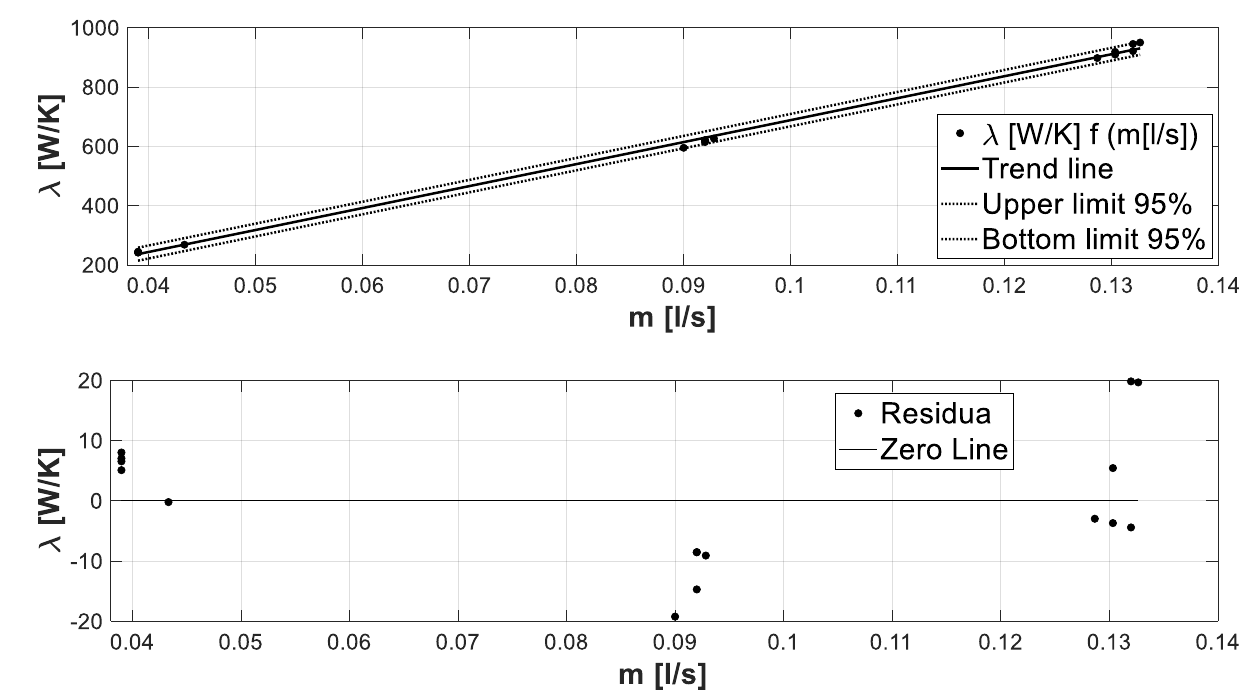
13 of 19 Figure 11. Impact of the circulator pump output on the value of the gain factor of the main path. Figure 12 shows the impact of the circulator pump output on the heat transfer rate of the heat exchanger. As in the case of the gain factor of the main path of the storage tank model, an increase in the output of the circulator pump causes an increase in the heat transfer rate of the heat exchanger. The relationship between the pump output and the